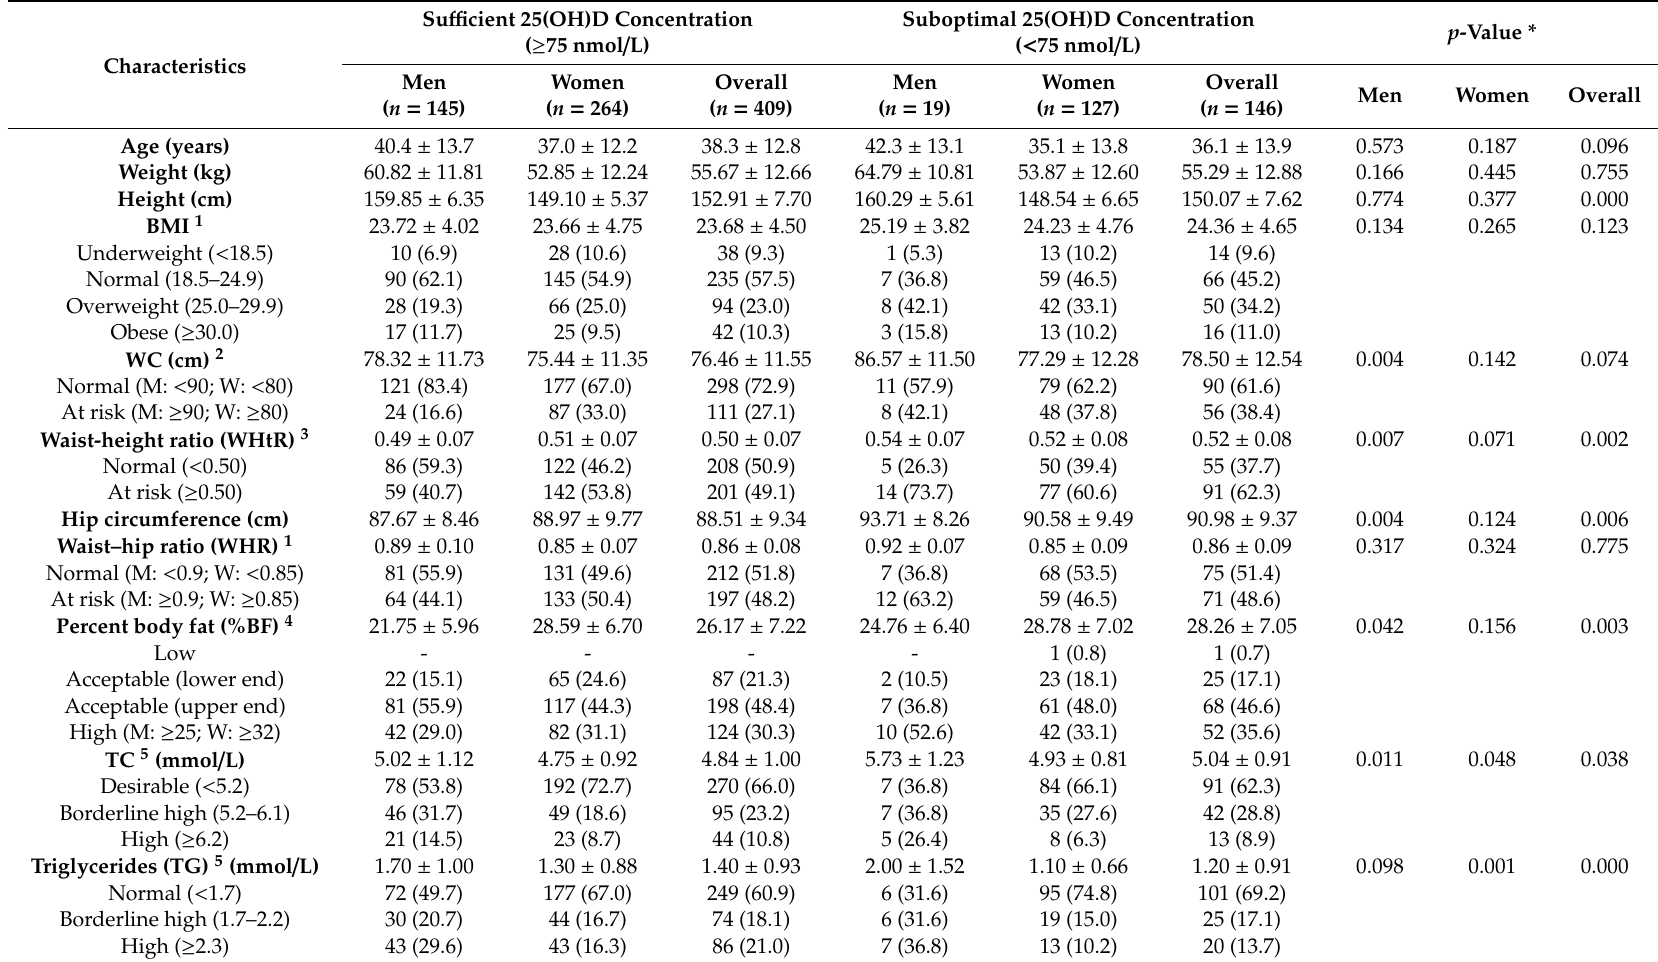
Table 3. Characteristics of respondents by serum 25(OH)D concentration ( N = 555) †